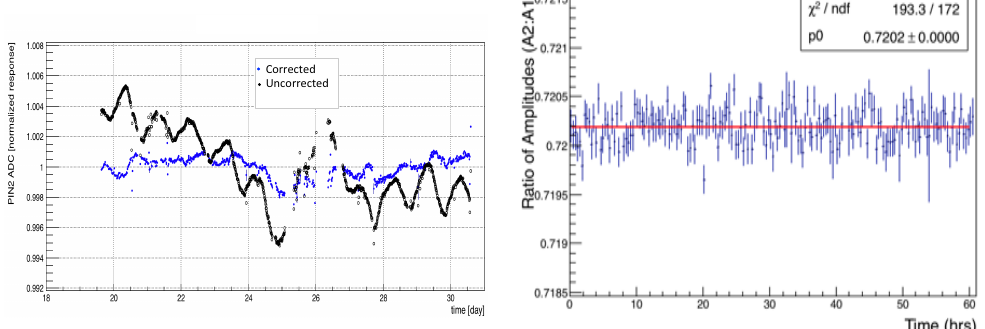
Figure 8. The stabilities of the SM ( Left ) and LM ( Right ) after applying temperature corrections.